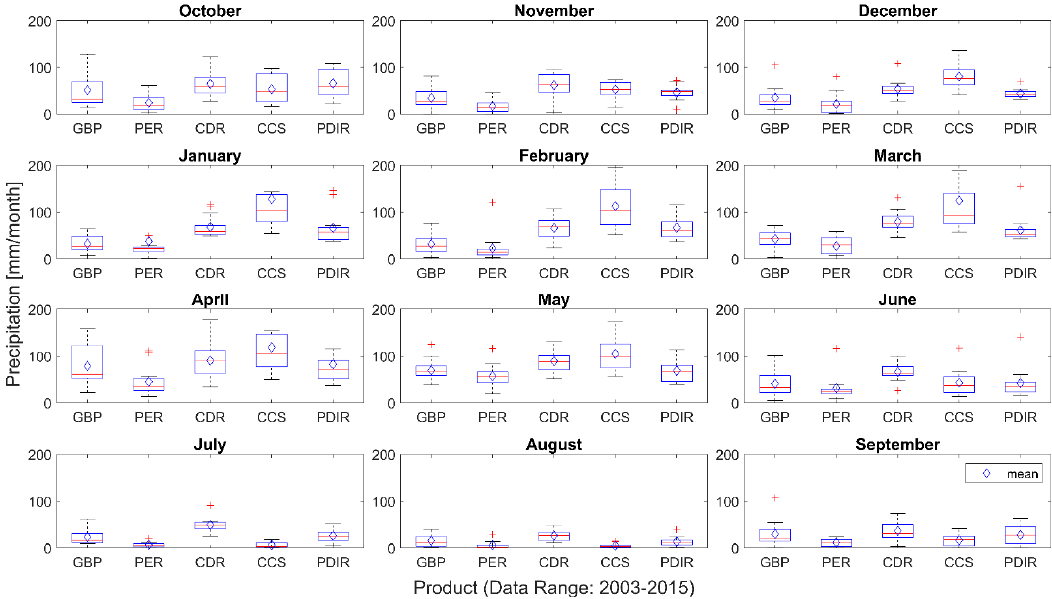
Figure 6. Monthly PVE of SBP data set with boxplots and whisker diagrams *GBP: Gauge-based Precipitation, PER: PERSIANN, CDR: PERSIANN-CDR, CCS: PERSIANN-CCS, PDIR: PERSIANN- PDIR-Now.